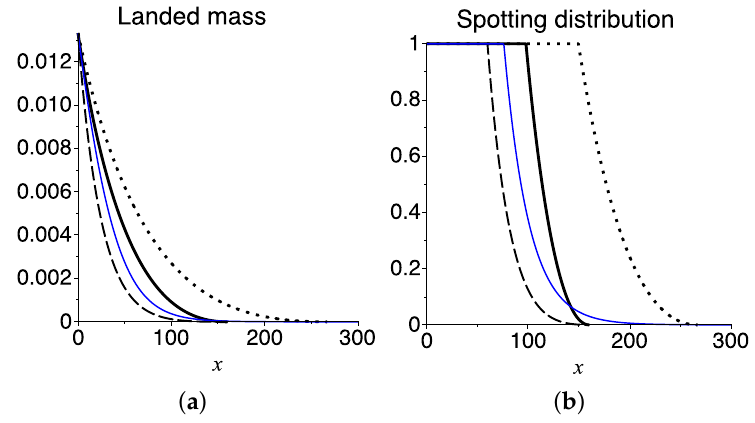
Figure 3. ( a ) Examples of landed mass distributions, with mass in kilograms along the y -axis and distance in metres along the x -axis; ( b ) Corresponding spotting distributions, dimensionless values on the y -axis and distance in metres along the x -axis. The parameters are from Table 1, with the base case in thick solid black, the slow burning case in dotted, the lower release height case in dashed and Tarifa’s model in thin solid